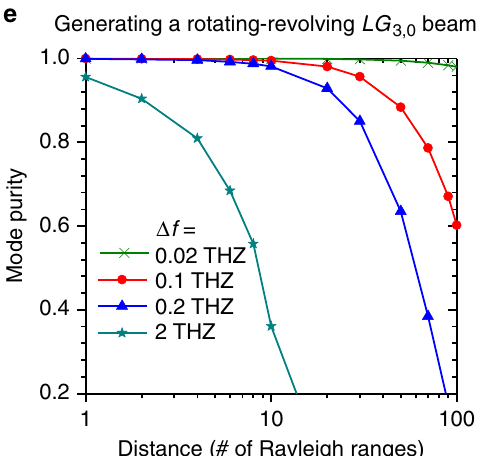
Fig. 4 Simulation results of diffraction effects for a spatiotemporal beam exhibiting both rotation and revolution. Propagation over distance of an offset conventional LG 3,0 in a the near- fi eld and b the far- fi eld for t = 0. Propagation along distance of a rotating-revolving LG 3,0 in c the near- fi eld and d the far- fi eld for t = 0. The fi rst and second rows in ( a ) – ( d ) are the intensity pro fi les of the propagating beams and the corresponding interferograms with Gaussian beams, respectively. As the propagation distance increases, the spatiotemporal beam counterclockwise revolves around the central axis. e The mode purity of a generated rotating-revolving LG 3,0 beam with different revolving speed (0.02 – 2 THz) when the propagation distance is varied from 0 to 100 z R , where z = 45.6 mm is the Rayleigh R